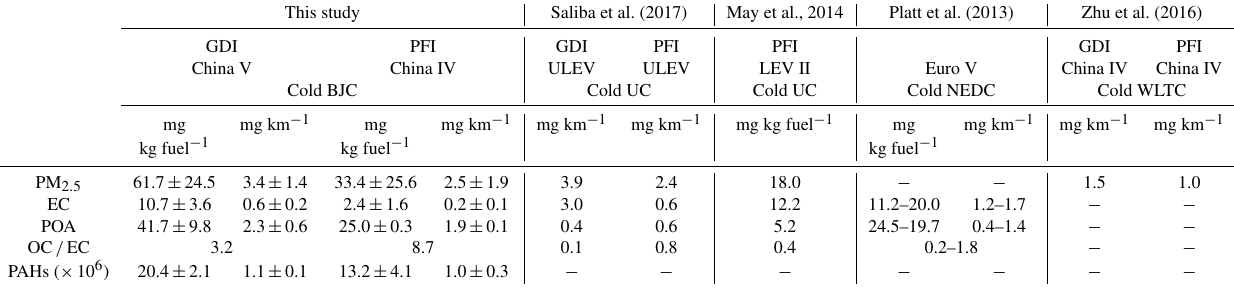
Table 4. EFs of primary aerosols, including carbonaceous aerosols and particulate polycyclic aromatic hydrocarbons (PAHs) from the GDI and PFI vehicles in this study and those of previous